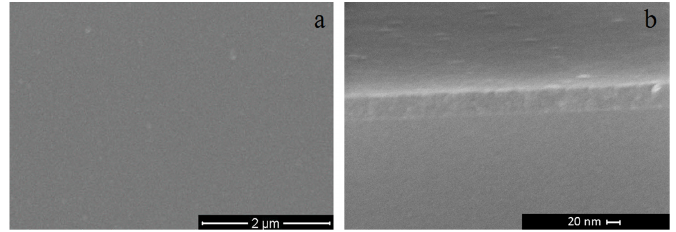
Figure 1. Typical SEM images of ( a ) surface morphology and ( b ) cross ‐ section of C1 ‐ F2 carbon films synthesized by PLD at the deposition conditions from Table 1.